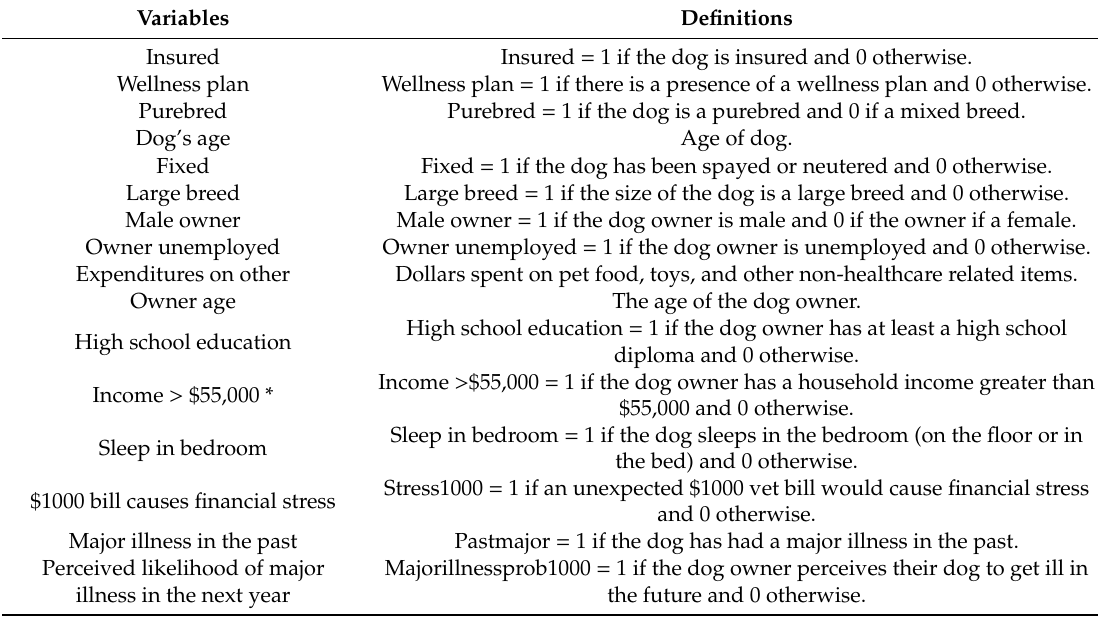
Table 1. Variables and variable definitions.